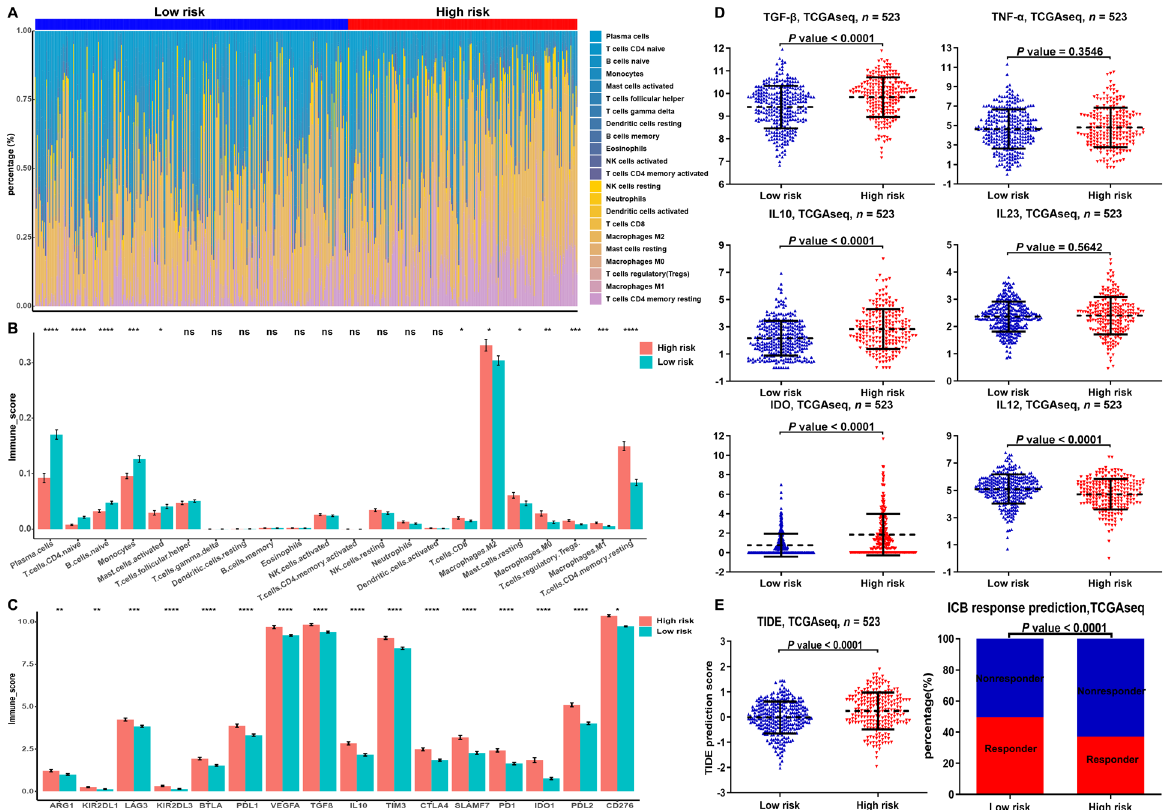
Figure 6. Proportion of TICs and exhausted immune response markers in the low- and high-risk groups of LGGs. (A) Bar chart showed the percentage of various TICs in the samples from the low-risk and high-risk groups; (B, C) bar chart demonstrated the difference in the expression of various immune cells and exhausted immune response markers between the low-risk and high-risk groups; (D) expression of M1- and M2-associated genes differences between the low- and high-risk groups in the TCGA database; (E) TIDE prediction difference in the high- and low-risk patients, and accumulative bar diagram showed that the LGGs with low-risk group (49.67%, 150/302) were more likely to respond to immune checkpoint blockade (ICB) immunotherapy than the LGGs with high-risk group (37.1%, 82/221). * P < 0.05, ** P < 0.01, *** P < 0.001, **** P <